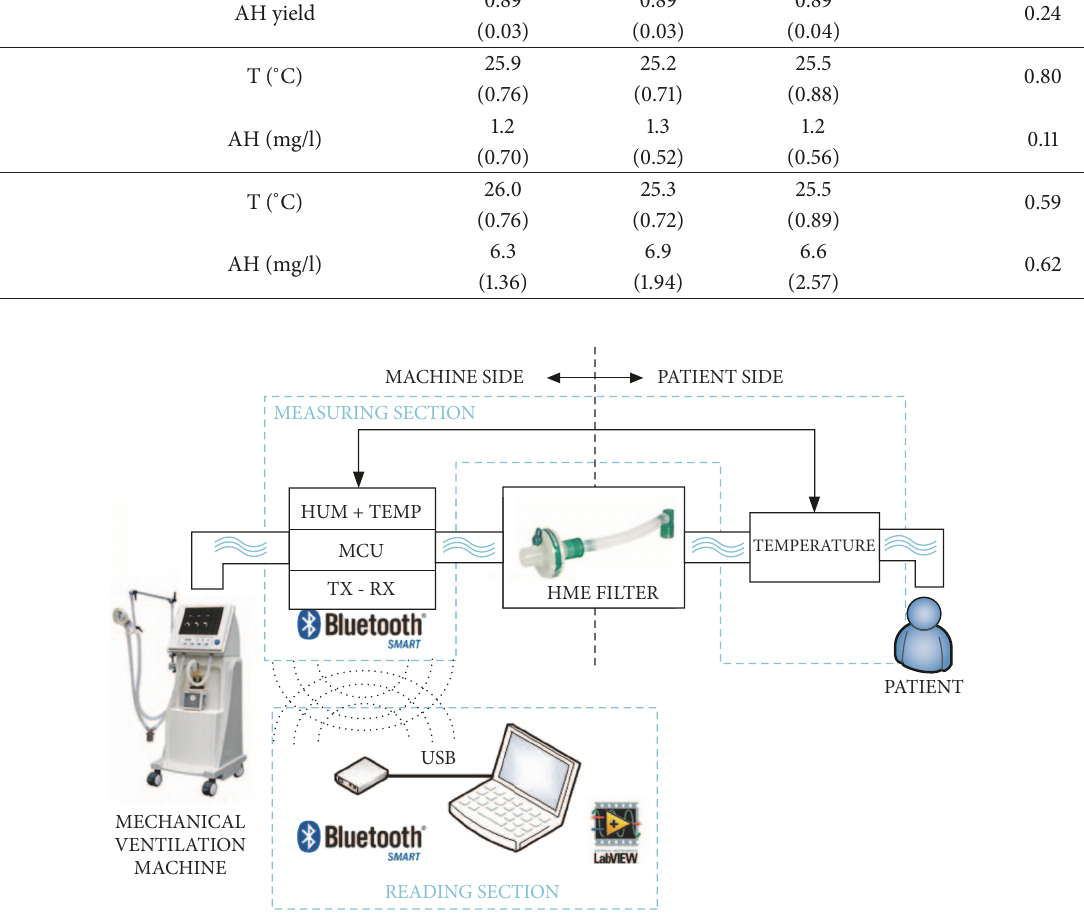
Figure 3: Data acquisition